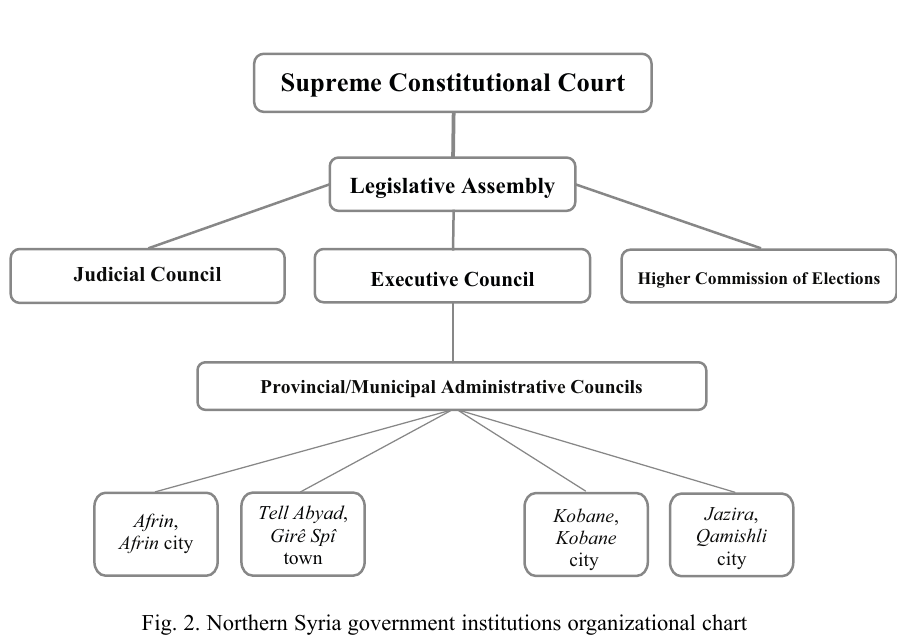
Fig. 2. Northern Syria government institutions organizational chart pursuant to the Constitution of the Rojava